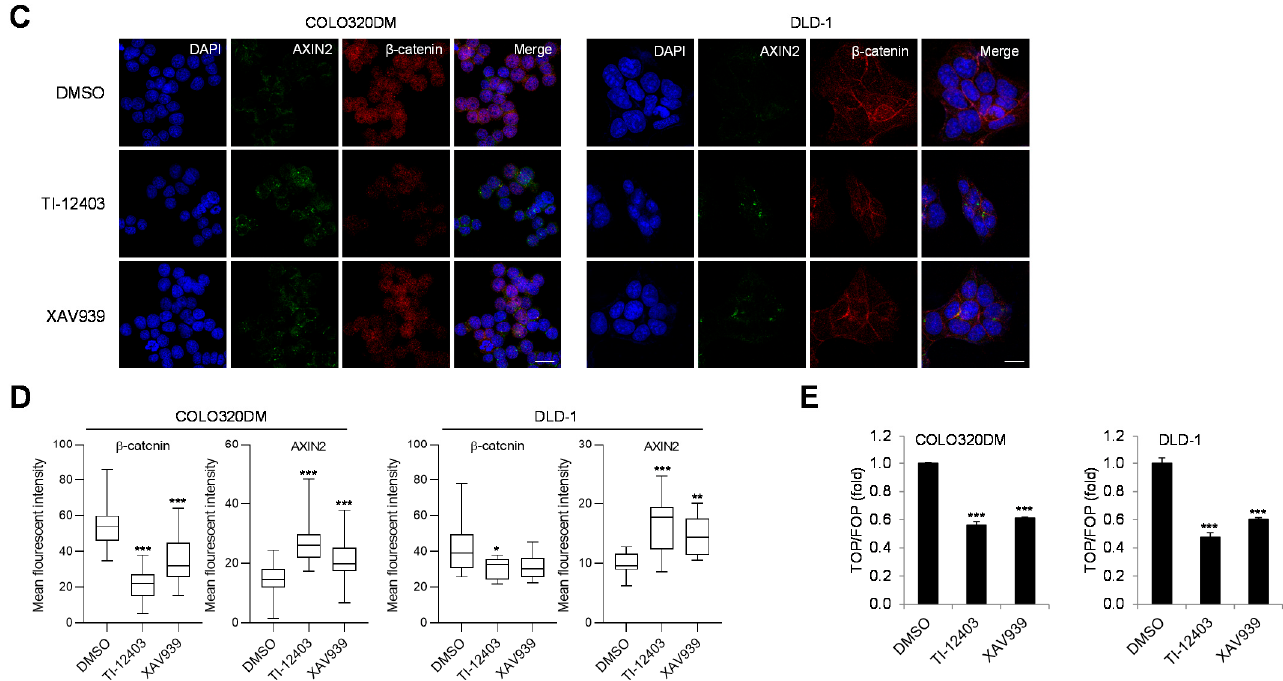
Figure 1. TI-12403 stabilizes AXIN2 and downregulates β -catenin signaling in COLO320DM and DLD-1 cells. Human colorectal cancer (CRC) COLO320DM and DLD-1 cells were treated with 10 µ M of each TI compound for 24 h. ( A ) mRNA expression levels of the indicated β -catenin target genes ( AXIN2 , BIRC5 , CCND1 , cMYC , and FGF20 ) were quantified using quantitative polymerase chain reaction (qPCR). XAV939 was used as a reference control. Data represent the mean ± standard deviation (SD) of three independent experiments. * p < 0.05, ** p < 0.01, *** p < 0.001 versus respective DMSO-treated cells. ( B ) Whole cell lysates were subjected to immunoblotting for detection of active β -catenin (ABC), total β -catenin, TNKS1/2, and AXIN2. β -actin was used as a loading control. The density of each band was measured by Image J software and normalized to that of β -actin. Data represent the mean ± SD of three independent experiments. * p < 0.05, ** p < 0.01 versus respective DMSO-treated cells. ( C ) COLO320DM and DLD-1 cells were treated with 10 µ M TI-12403 and immunostained for AXIN2 (green) and β -catenin (red). Nuclear DNA was counterstained with DAPI (blue). Scale bar, 20 µ m. ( D ) Quantification of the mean fluorescence intensity in Figure 1C. * p < 0.05, ** p < 0.01, *** p < 0.001 versus corresponding cells. ( E ) COLO320DM and DLD-1 cells were transfected with either TOP- (wild-type TCF binding sites) or FOP- (mutated TCF binding sites) flash reporter plasmid and then treated with 10 µ M TI-12403 for 48 h. Transcriptional activity was measured with a luciferase reporter assay system and was calculated by dividing the TOP ratio by the FOP ratio (TOP/FOP ratio). Data represent the mean ± SD of three independent experiments. *** p < 0.001 versus respective DMSO-treated cells. Table 1. IC 50 ( µ M) of TI-12403 against TNKS1 and TNKS2.